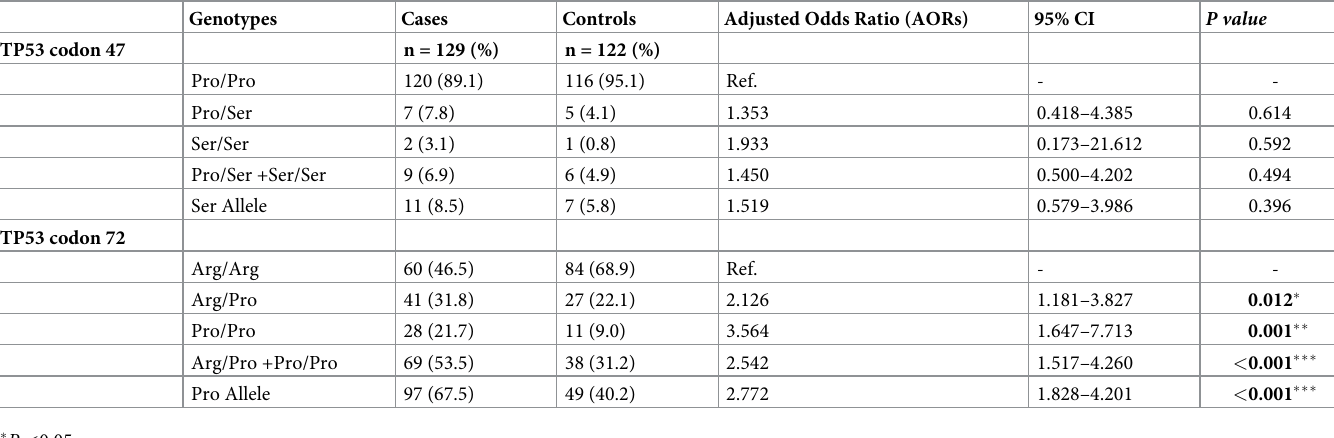
Table 3. Genotype frequencies of TP53 gene polymorphisms in cervical cancer patients and